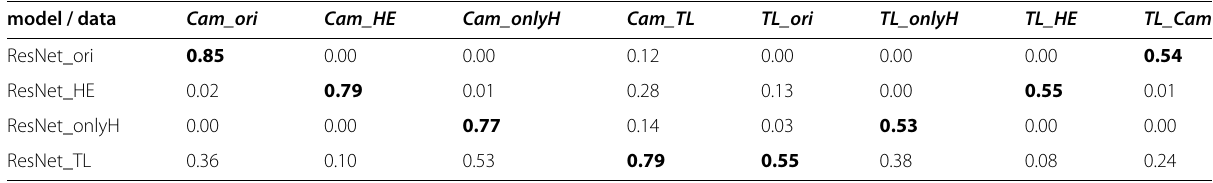
Table 5 Kappa-values for the ResNet models that were trained on different versions of the Camelyon16 data